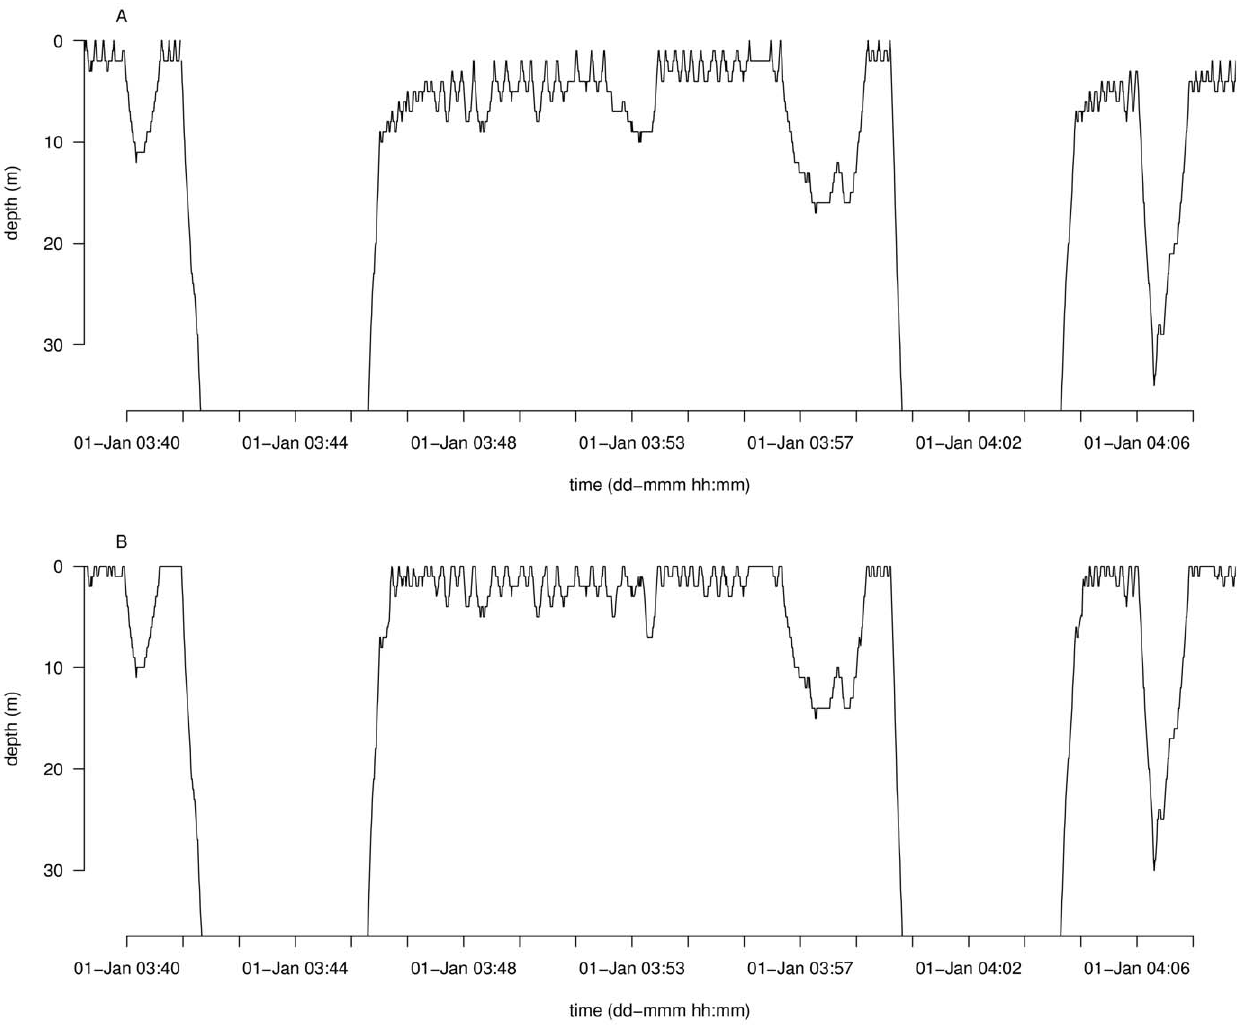
Figure 7. Comparison of ZOC adjusted and unadjusted TDR data from a short-finned pilot whale. Input time series (A), corresponding to period presented in [11], and corrected depth (B). The y-axis limits are restricted to the top 35 m of this period for clarity. Date and time on x-axis were set arbitrarily because input consists of seconds.